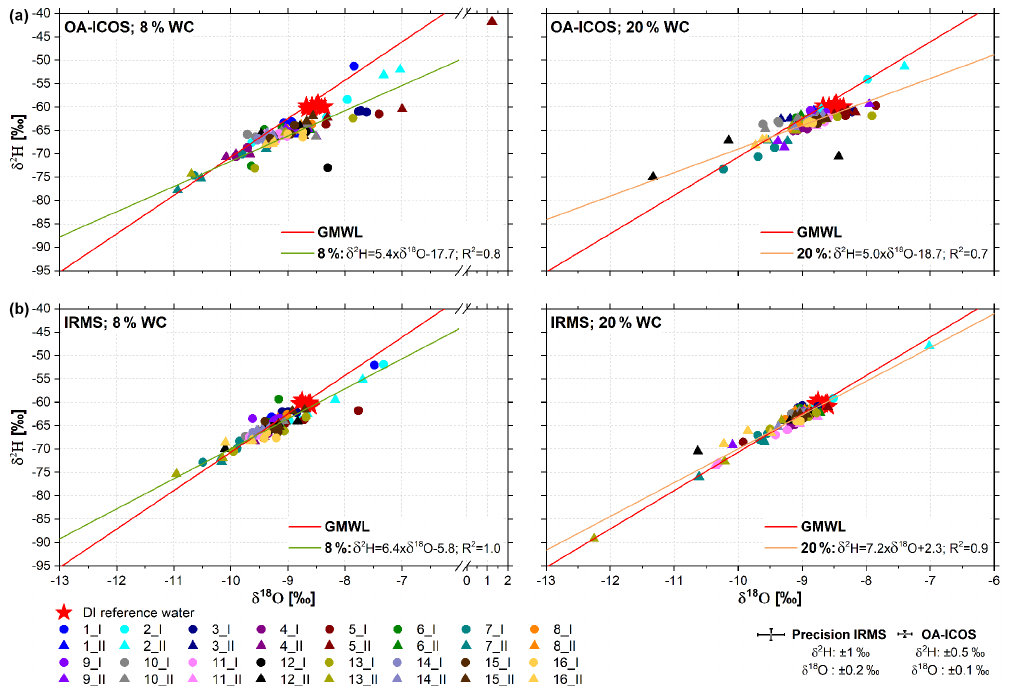
Figure 6. Dual isotope plots of silty sand extracts for 8 and 20%WC in comparison to reference DI water (red asterisks) for OA-ICOS and IRMS data (panels a, b , respectively) from the 16 participating labs (different colors represent different labs) and both extraction methods (lab procedure: I; predefined: II). For reference, plots include the global meteoric water line (GMWL, solid red line) and soil water regression lines for 8 and 20%WC (solid green and orange lines,